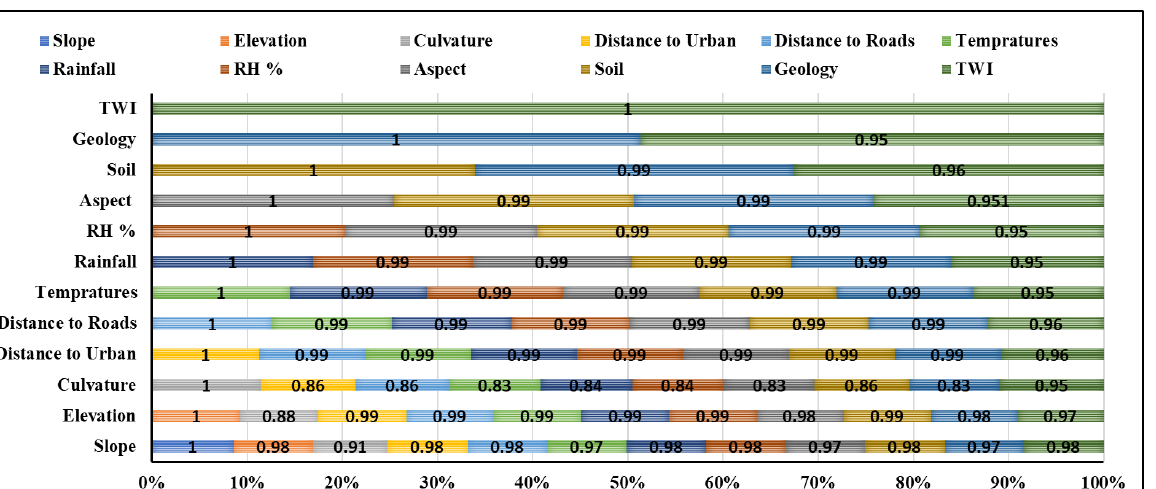
Figure 9. Spatial distribution of the NDVI condition factors: ( a ) elevation, ( b ) soil map, ( c ) slope, ( d ) aspect, ( e ) topographic wetness index, ( f ) golgoy map, ( g ) culvature, ( h ) temperature, ( i ) rainfall, ( j ) humidity, ( k ) distance to urban area, and ( l ) distance to roads.